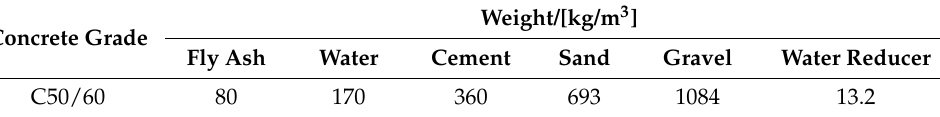
Figure 3. Stress–strain curve of HS steel. Table 2. Mix proportion of concrete.